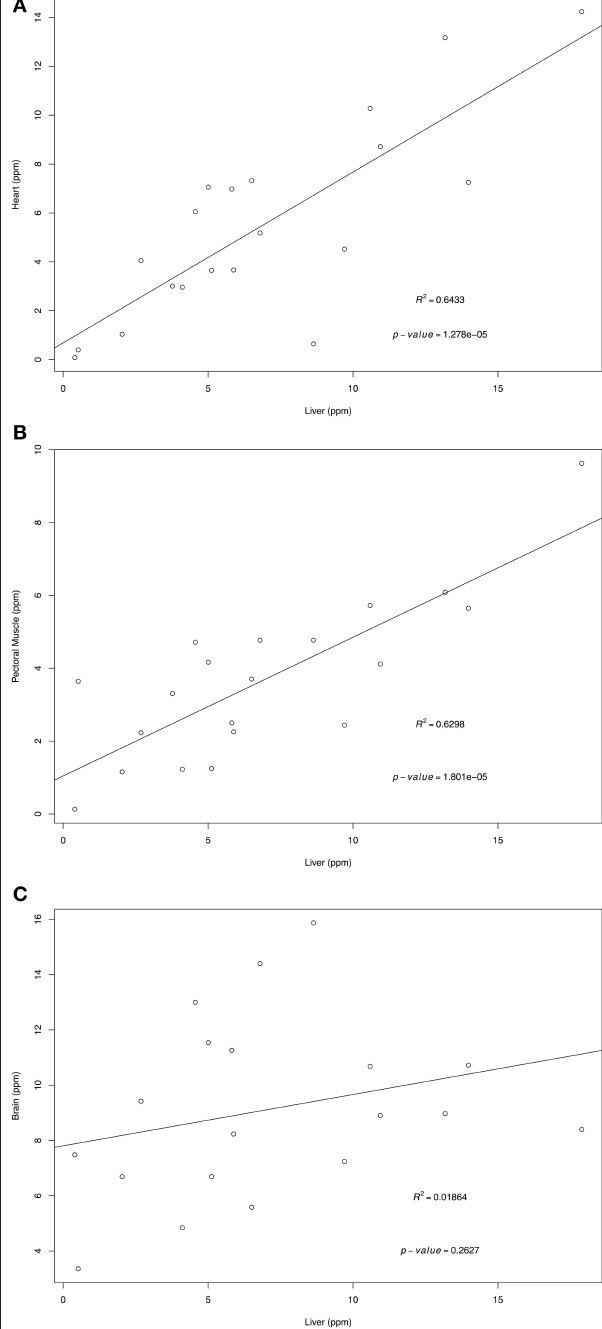
mass of 0.05 g), α -tocopherol concentrations were very close to expected concentrations (CV = 6.7%), thus supporting the precision of the analytical